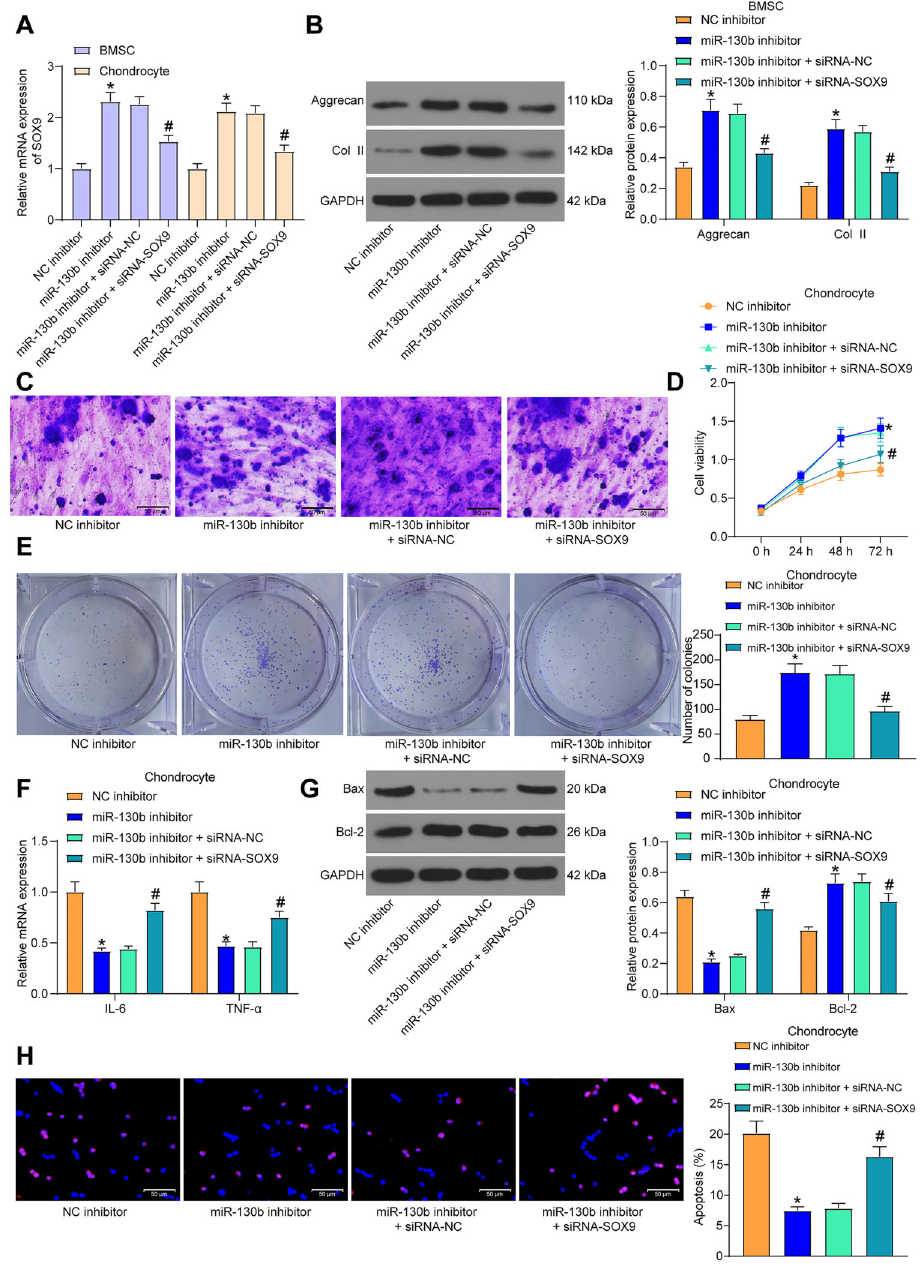
Figure 5. SOX9 silencing weakened the inhibition of miR-130b inhibitor on chondrogenic differentiation of bone marrow mesenchymal stem cells (BMSCs) and chondrocyte growth. A , Expression of SOX9 in BMSCs and chondrocytes was measured by RT-qPCR. B . Western blot analysis measured the protein level of aggrecan and Col II in BMSCs. C , Toluidine blue staining indicated the extracellular matrix synthesis of BMSCs (scale bar, 50 m m). D , MTT method measured the viability of chondrocytes. E , Colony formation ability of chondrocytes. F , RT-qPCR measured the expression of interleukin (IL)-6 and tumor necrosis factor (TNF)- a in chondrocytes. G , Western blot analysis measured the expression of apoptosis-related factors in chondrocytes. H , TUNEL staining examined the apoptosis rate of chondrocytes (scale bar, 50 μ m). The data in panels A , E , and H were analyzed using one-way ANOVA, and the data in panels B , D , F, and G were analyzed using two-way ANOVA. *P o 0.05 compared to cells transfected with NC inhibitor; # P o 0.05 compared to cells transfected with miR-130b inhibitor + siRNA-NC. Experiments were repeated 3 times independently. NC: negative